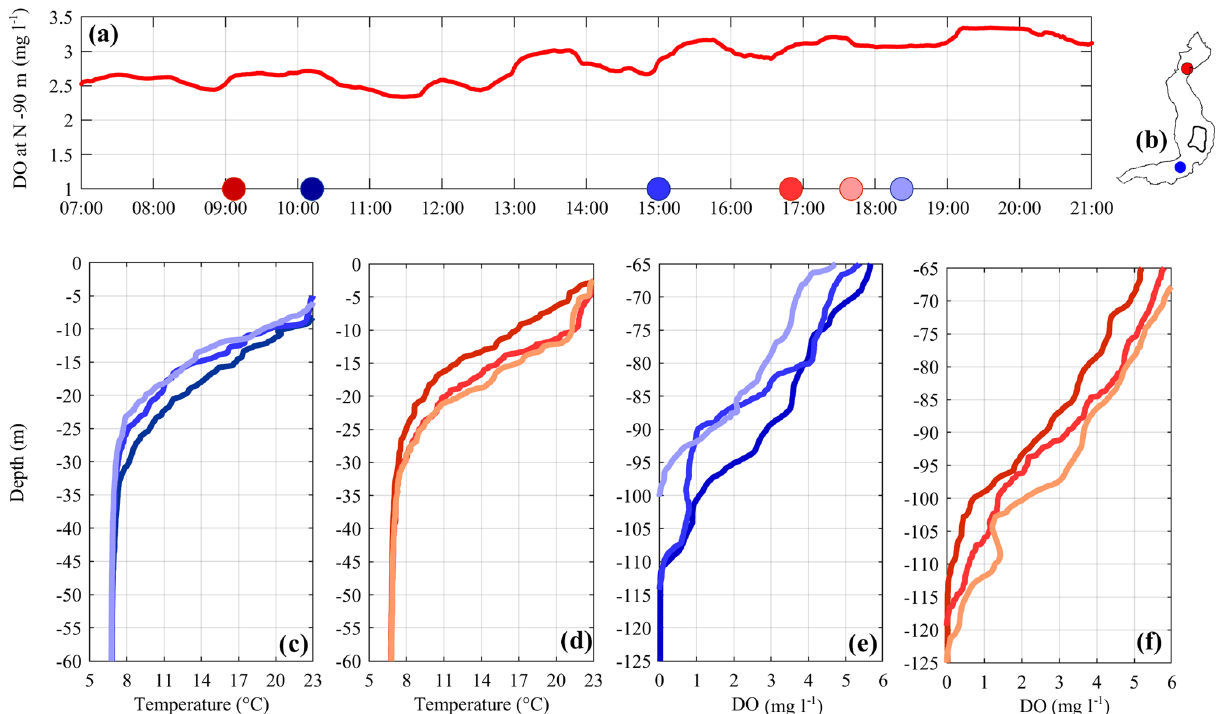
Figure 7. (a) DO concentration at 90m in depth recorded at station LS-N on 21 July 2017. Colored dots on the x axis indicate the sampling time of the vertical profiles shown in (c–f) . Panels (c) and (d) compare the profiles of temperature between 0 and 60m, while panels (e) and (f) compare the profiles of DO between 65 and 125m. Red and blue colors refer to the northern and southern sampling locations (see b ),